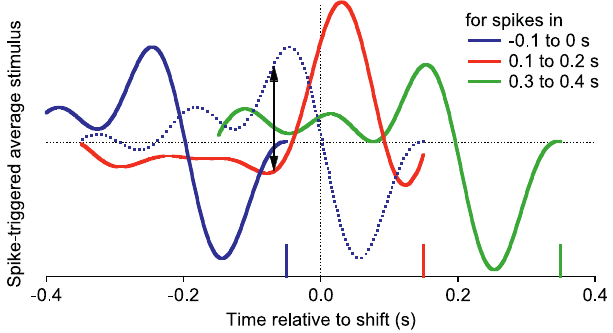
Figure 10. Dynamic Change of a Ganglion Cell’s Visual Message The spike-triggered average stimulus of an On-Off cell, plotted for spikes (vertical tick marks) emitted in various 0.1-s intervals surrounding a peripheral shift. Each curve depicts the average intensity time course that caused a spike, and thus represents the average message such a spike sends to the brain. Dotted curve: the visual message that would have been conveyed by spikes in the interval 0.1–0.2 s, if the peripheral shift at 0 s had not occurred. Note that the dotted and solid curves for this interval differ significantly even at time points before the shift (arrows).